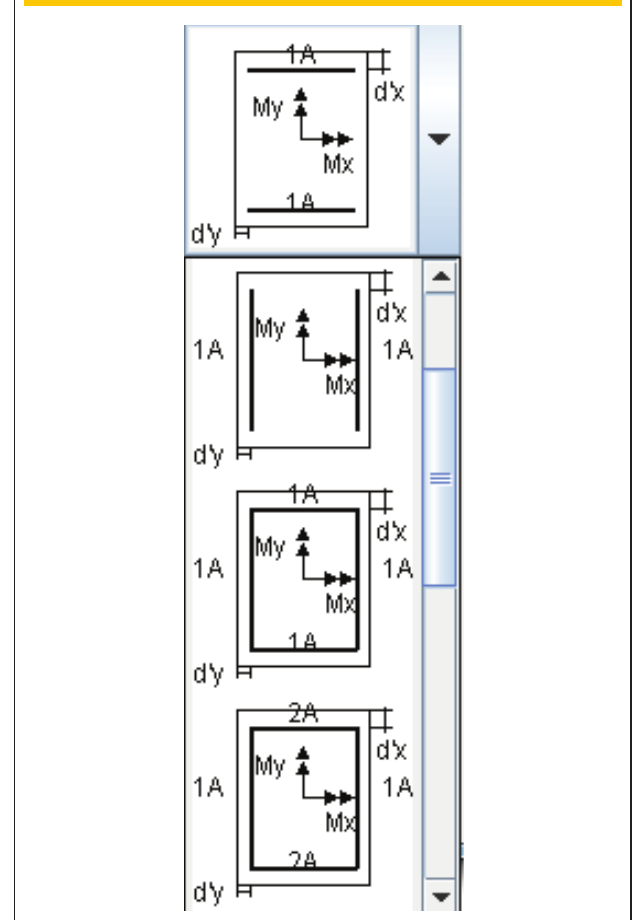
Figure 3 – Reinforcement distribution